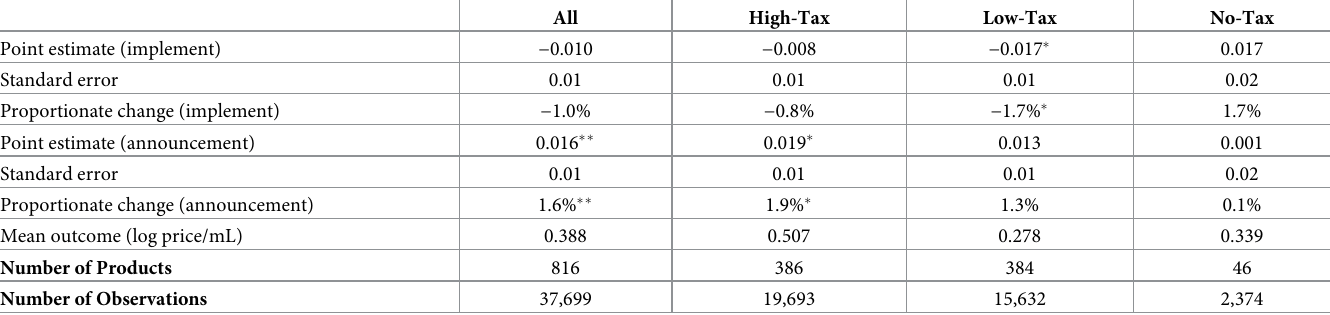
Table 3. Price regression model (log price/mL) with date of implementation and date of announcement. All High-Tax Low-Tax